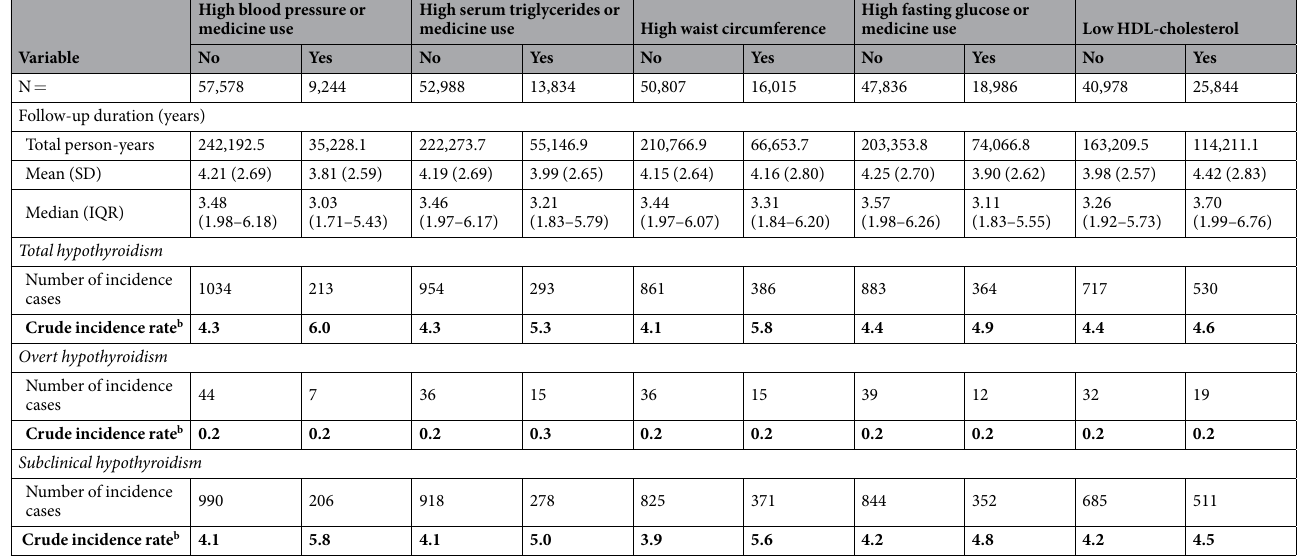
Table 3. Follow-up duration, number of incident cases, and crude incidence rate of hypothyroidism for participants with and without individual component of metabolic syndrome at the baseline (N = 66,822 a ). a Excluding participants with prevalent hypothyroidism at the baseline (N = 1,151), and those with missing information or measurement error of thyroid function test (N = 631), and those who had ever received undetermined thyroid medicine during the follow-up period (N = 139). b Crude incidence rate: per 1,000